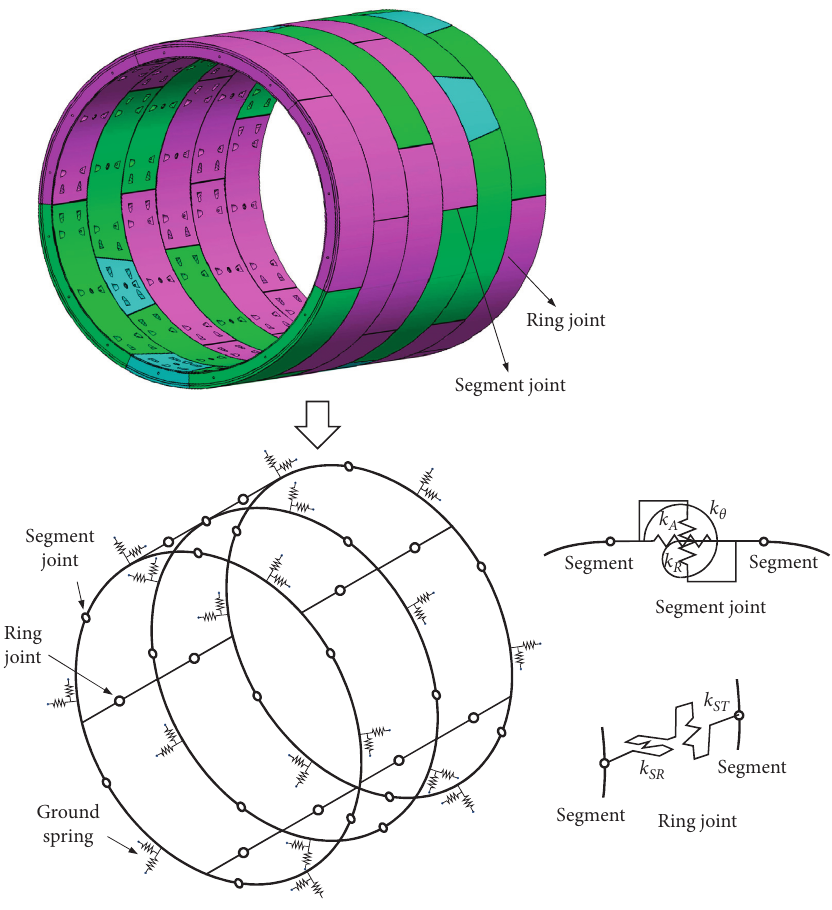
Figure 8: Beam-spring model.